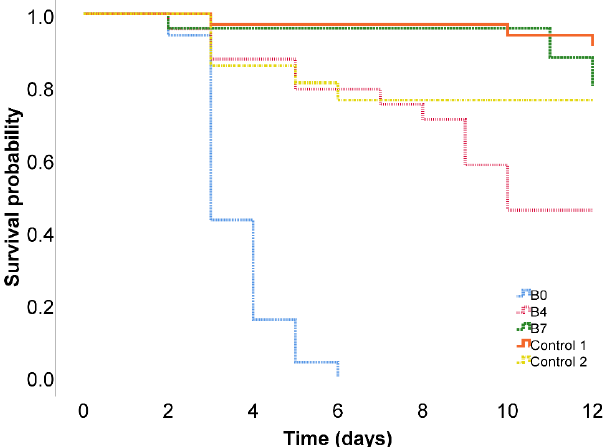
Figure 1. Survival curves of Aphis gossypii reared on melon plants sprayed with BTH (benzo-(1,2,3)-thiadiazole-7-carbothioic-acid S-methyl ester) to the point of run-off, zero (B0), four (B4), and seven aphid